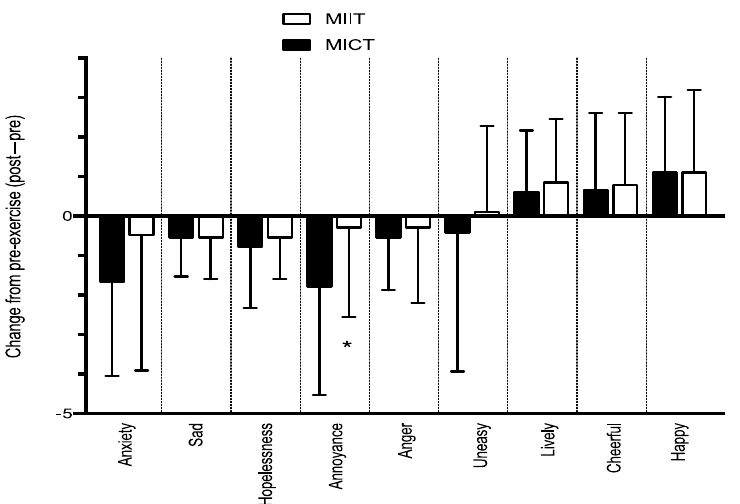
Figure 1. Acute mood changes after MICT and MIIT trials. * Significant difference in changes in self-reported annoyance after MICT vs. MIIT, p < 0.01.